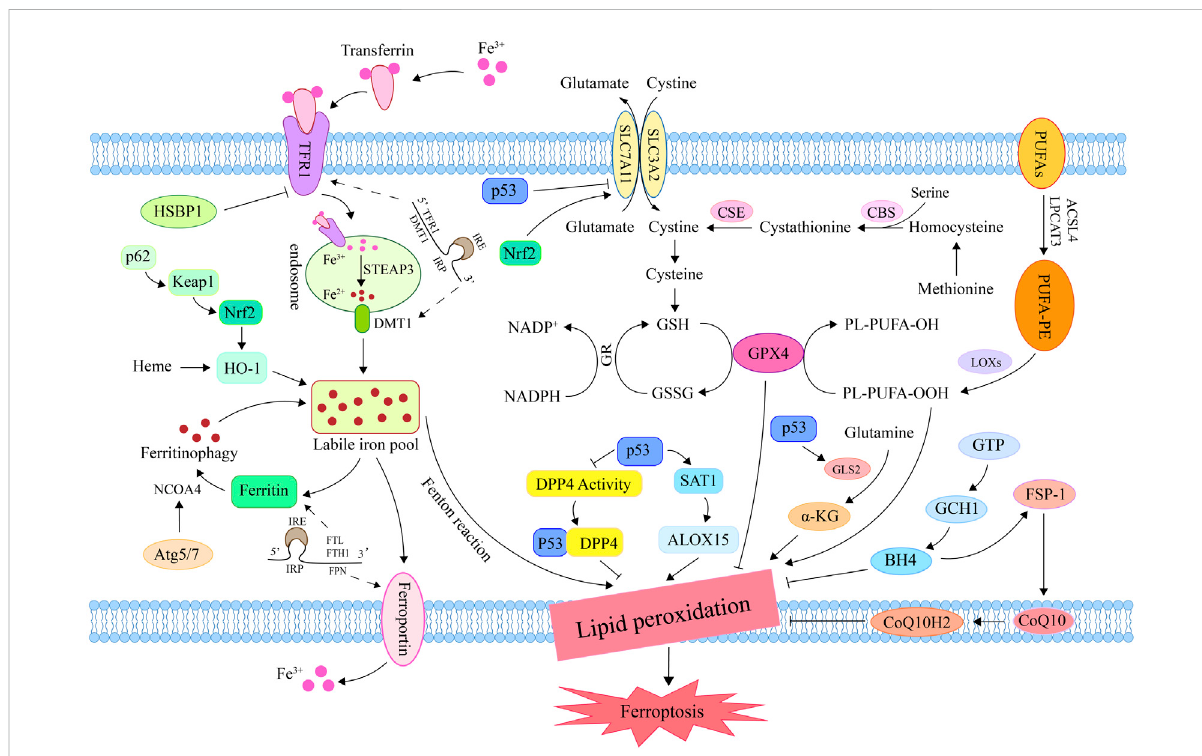
FIGURE 2 Mechanisms for regulating ferroptosis. IronincirculationbindstoTFR1andenterstheendosome via endocytosis;then,steap3convertsFe 3+ to Fe 2+ . DMT1 transports Fe 2+ into the lip in order to promote unstable iron accumulation and induce ferroptosis via the Fenton reaction. Methionine generates cysteine under the action of CBS and CSE for GSH synthesis. Inhibition of system Xc − reduced GSH synthesis and inactivated GPX4, promoting lipid peroxide accumulation and inducing ferroptosis. Under the catalysis of ACSL4, LPCAT3, and LOX, PUFA lipid peroxidation resulted in ferroptosis. By promoting iron release, the ferritin autophagy-related genes Atg5, Atg7, and NCOA4 induce ferroptosis. By in fl uencing genes related to iron/heme metabolism and amino acid metabolism, Nrf2 plays a signi fi cant role in the regulation of ferroptosis. By inhibiting DPP4 activity and systemic SLC7A11 expression, or by activating SAT1 and GLS2, P53 can induce ferroptosis. FSP1 prevents lipid peroxidation by converting CoQ10 to CoQ10H2, thereby inhibiting ferroptosis. GCH1 blocks the chain propagation of lipid peroxidation by catalyzing GTP to generate BH4. TFR1, transferrin receptor 1; DMT1, divalent metal transporter 1; CBS, cystathionine β -synthase; CSE, cystathionine gamma-lyase; GSH, glutathione; GPX4, glutathione peroxidase 4; ACSL4, Acyl-CoA synthetase long-chain family member 4; LPCAT3, lysophosphatidylcholine acyltransferase 3; LOX, lipoxygenase; PUFA, polyunsaturated fatty acid; Atg5, autophagy-related gene 3; Atg7, autophagy-related gene 7; NCOA4, nuclear receptor coactivator 4; Nrf2, nuclear factor erythroid 2-related factor 2; DPP4, dipeptidyl-peptidase 4; SLC7A11, solute carrier family 7 member 11; SAT1, spermidine/spermine N1-acetyltransferase 1; GLS2, glutaminase 2; FSP1, ferroptosis suppressor protein 1; CoQ10, ubiquinone; CoQ10H2, ubiquinol; GCH1, GTP cyclohydrolase-1; GTP, Guanosine triphosphate; BH4,